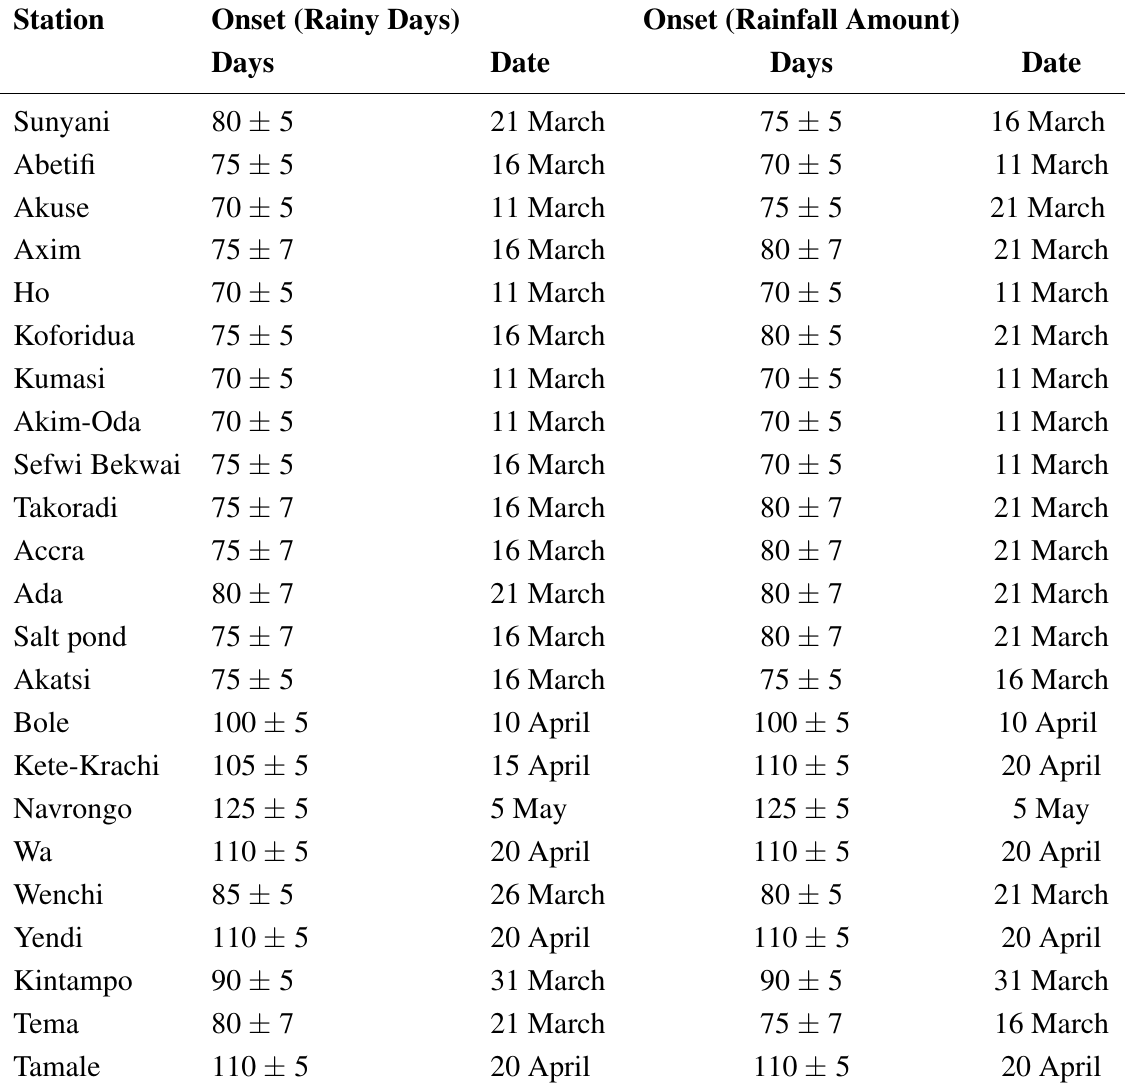
Table 1. Summary of rainfall onset days/dates for the GMet